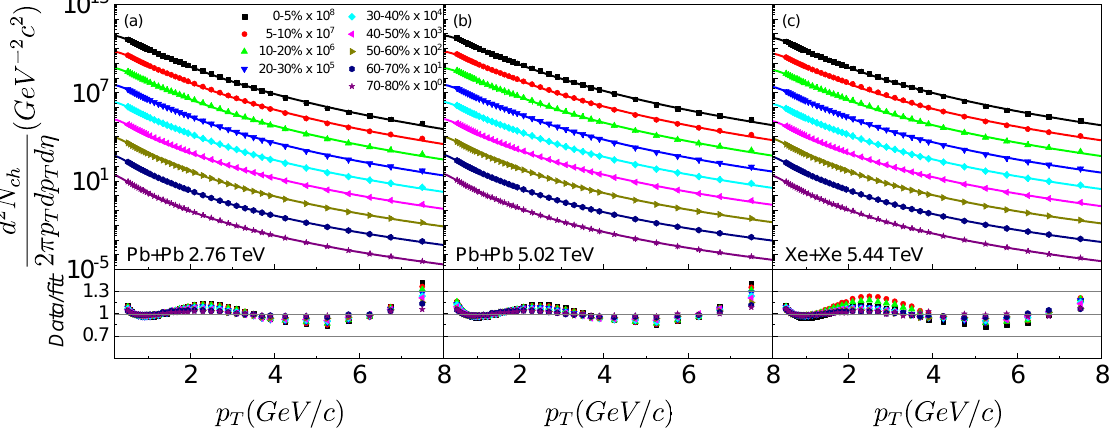
√ s NN = 2.76 and 5.02 TeV and